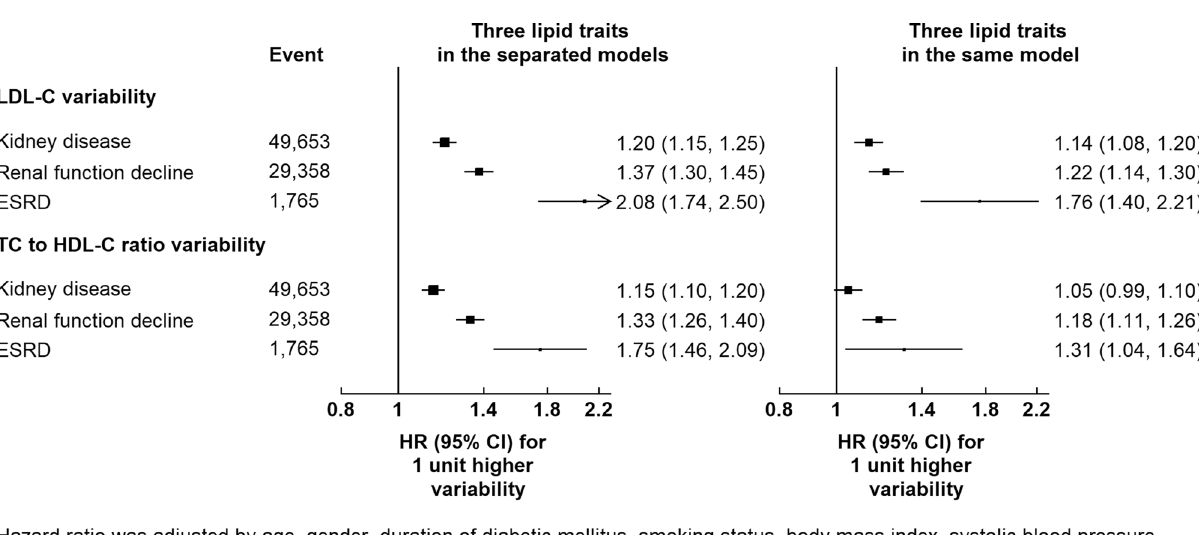
Figure 1. Hazard ratios for the association of a unit increase in LDL-C, TC to HDL-C ratio and triglyceride variability with kidney disease, renal function decline and ESRD from Cox regression models adjusted for baseline covariates.